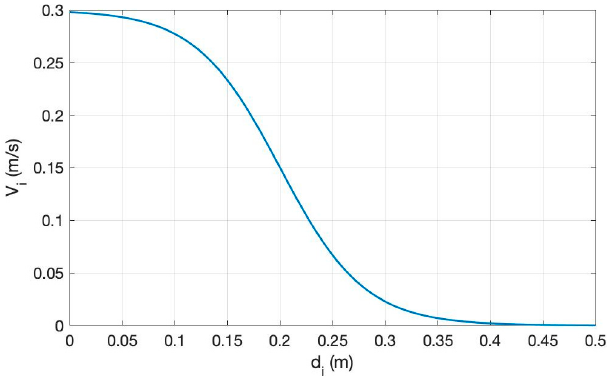
Figure 7. Magnitude of the repulsive velocity (cid:1848) (cid:3036) versus the human-robot distance.